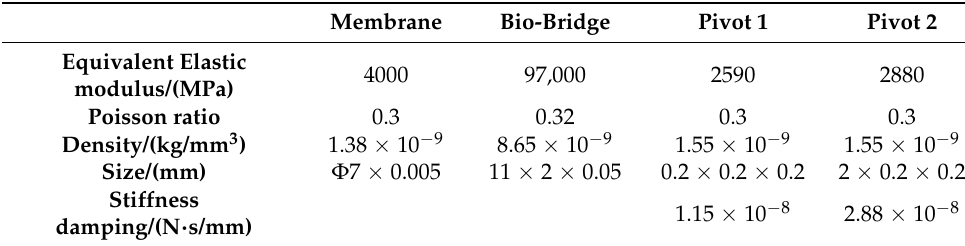
Table 1. Structural parameters of the established inter-membrane bridge structure.